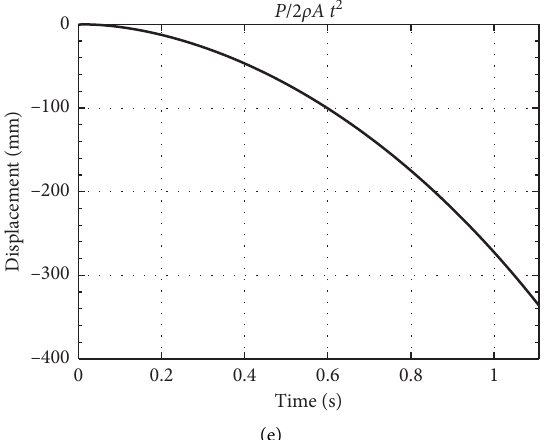
Figure 5: Plot of the five terms of equation (3) in the considered case study. The title of each subfigure identifies the corresponding term.